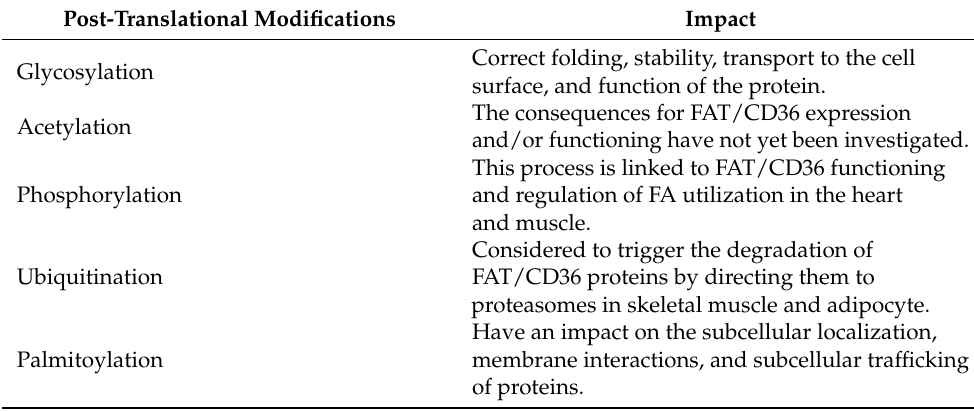
Table 2. Post-translational modifications in